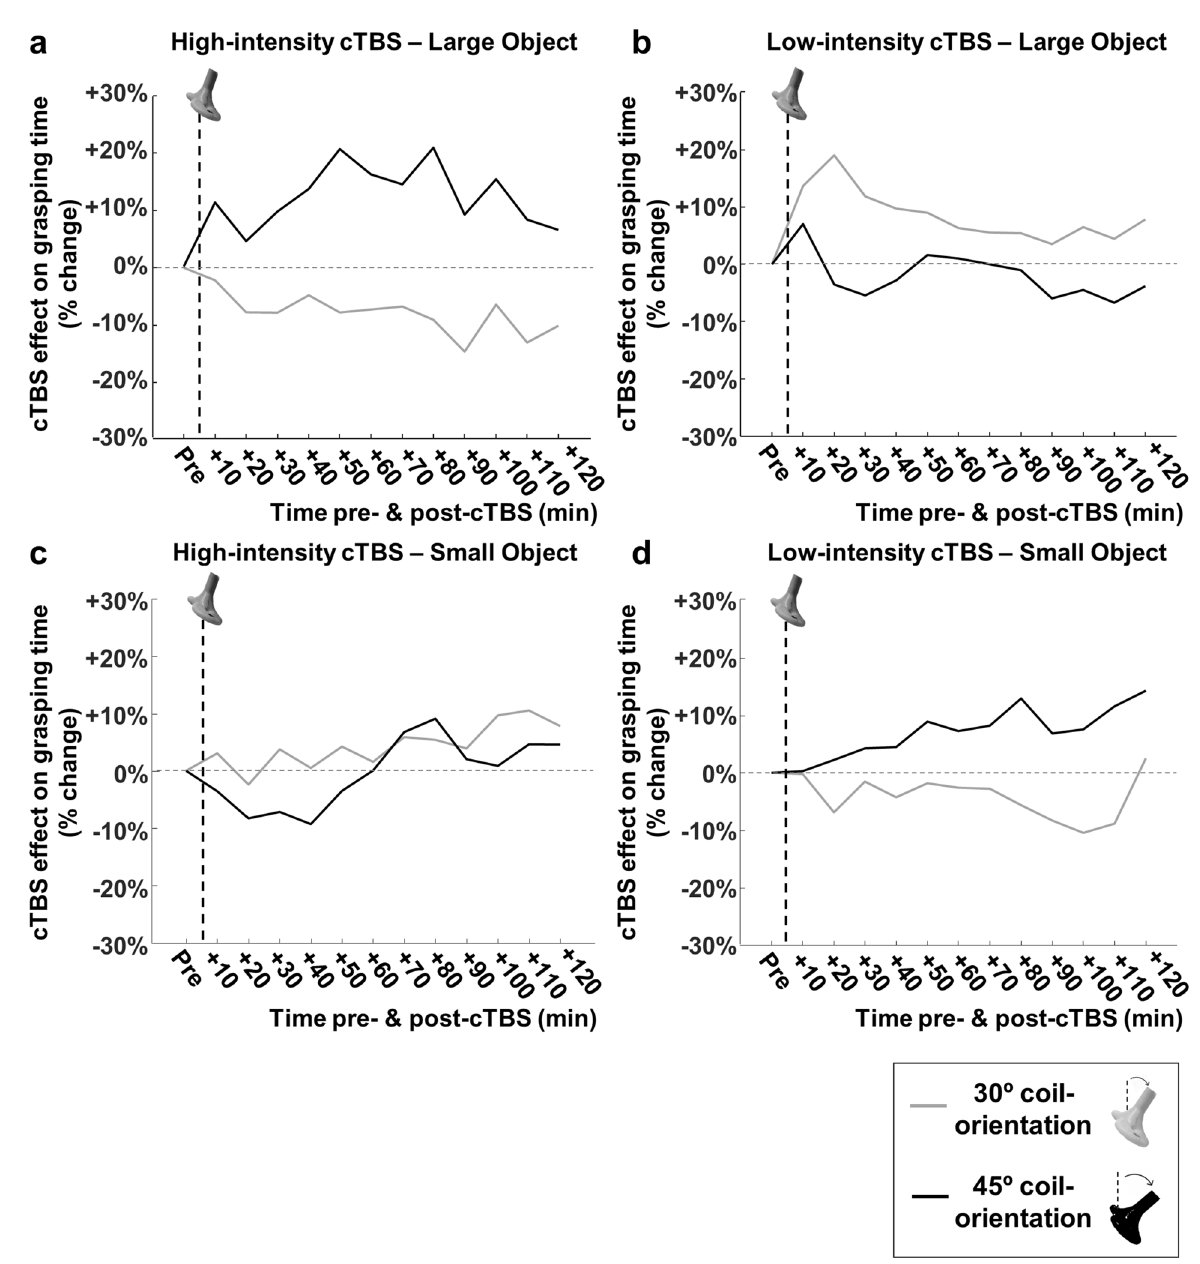
Figure 6. Coil angle and cTBS effect on grasping time. ( a , b ) Average percent change in grasping time (compared to no-stimulation) for high- ( a ) and low-intensity cTBS ( b ) when grasping the larger object, in monkey D. Black: 45-degree coil angle. Gray: 30-degree coil angle. The lighter dashed line (horizontal) represents the baseline grasping time. The thicker dashed line (vertical) indicates the stimulation time (cTBS). ( c , d ) Average percent change in grasping time (compared to no-stimulation) for high- ( c ) and low-intensity cTBS ( d ) when grasping the smaller